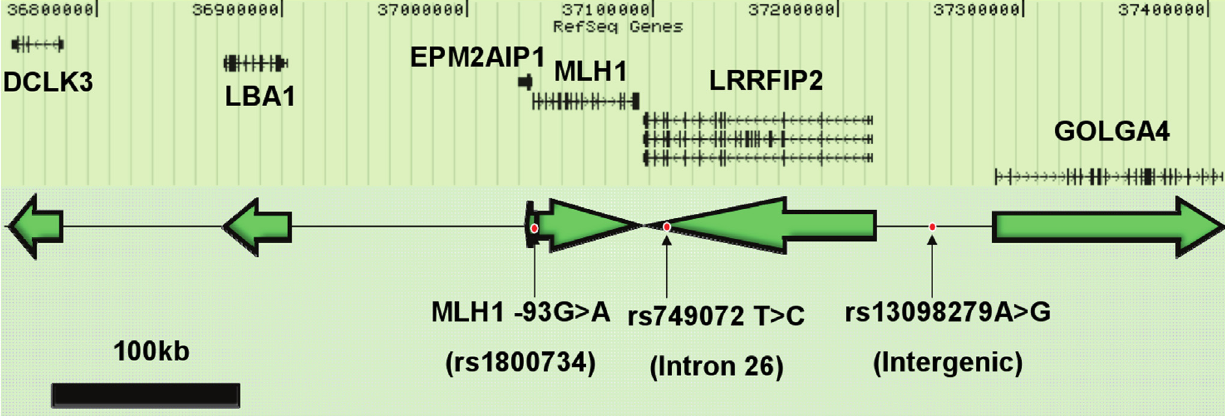
Figure 2. Region of chromosome 3 examined with genes and 3 SNPs. A total of 99 polymorphisms were examined in the Ontario samples across a 500kb region of chromosome 3 surrounding the MLH1 gene. Genes in this region are outlined (top panel) along with their transcriptional directionality (bottom panel). The three polymorphisms of interest are indicated. Modified from Ensembl (www.ensembl.org).